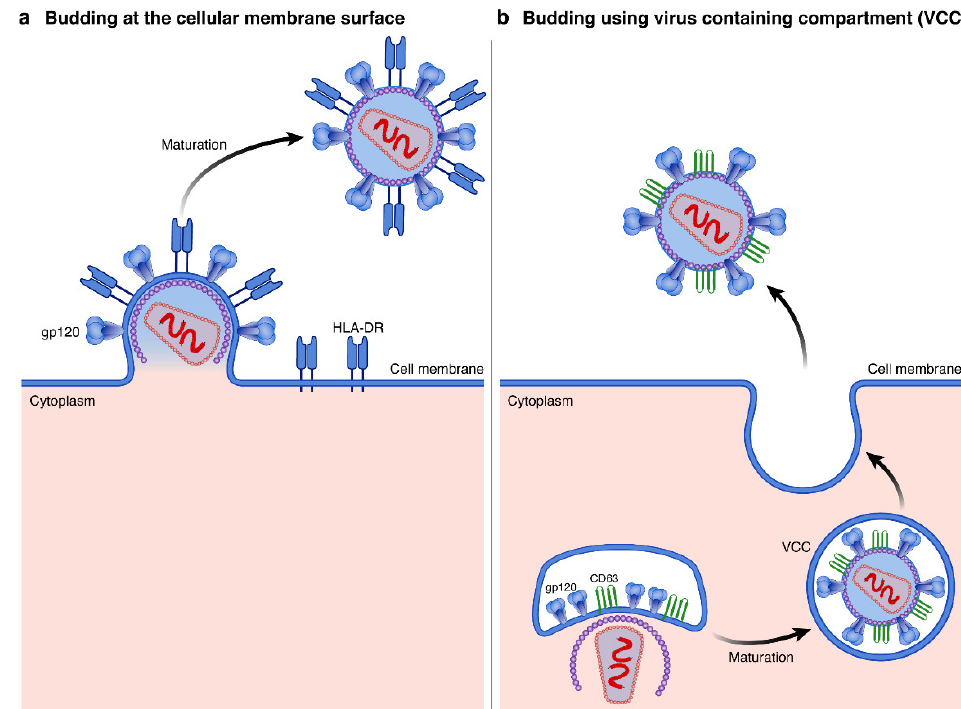
Figure 3. HIV virion assembly and maturation routes: The assembly of HIV virions might occur either ( a ) using the lipid membrane at the cell surface, mostly in lymphoid cells (e.g., HLA-DR in blue) or ( b ) using virus containing compartments, mostly in myeloid cells (e.g., CD63 in green).